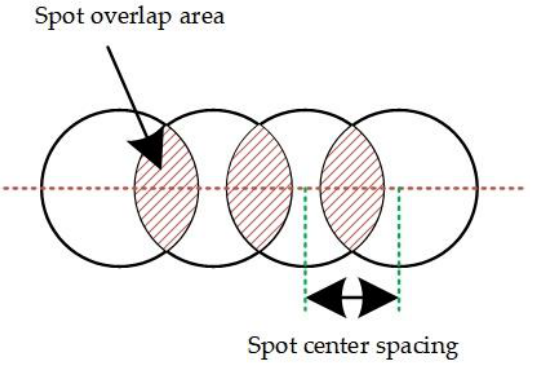
Figure 2. Spot overlap diagram.